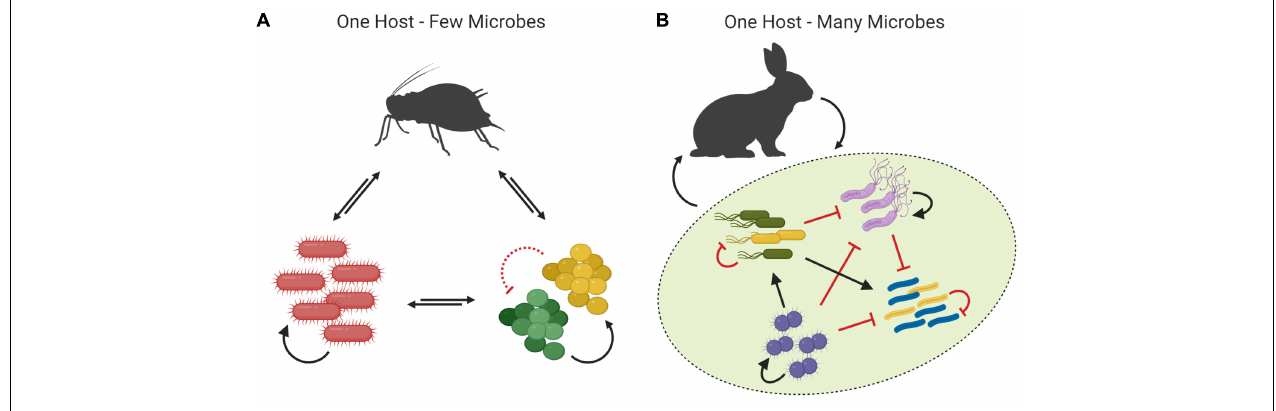
FIGURE 2 | The Inner Ecosystem. Different symbioses vary in the complexity of the inner ecosystem, the stage on which positive (black arrows) and negative (red arrows) interactions occur between microbes and their host and among microbes of the same or different species (represented by microbes of different colors and shapes, respectively). (A) Animals that harbor only few symbiont species have “simple” inner ecosystems. In such symbioses, interactions are usually mutually beneficial, and conflicts among microbes, or between microbes and the host, are limited due to strong, symbiont-specific host control and/or self-enforcement. (B) Animals that harbor many different symbiont species have “complex” inner ecosystems. In such symbioses, the host and individual microbe species are thought to benefit, on average, from their association, but symbiont-specific host control is limited such that the host can be considered to interact with the microbiota as a whole (green area). Because of the limited specificity of host control and the high diversity of the microbiota, interactions among different genotypes and symbiont species can be both cooperative or